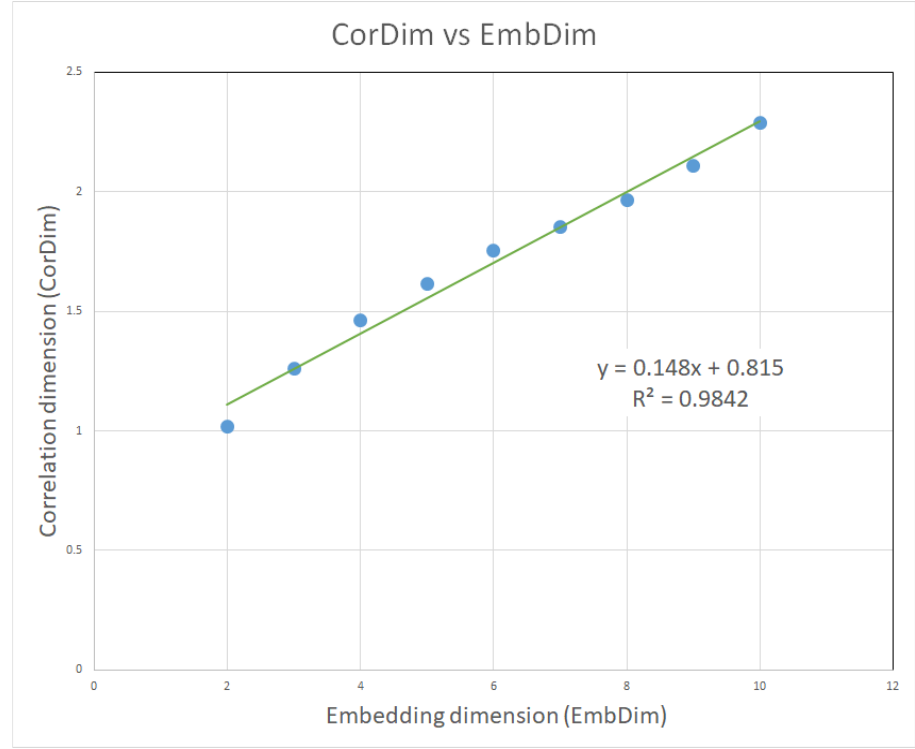
Figure 16. The slope of the autocorrelation dimension versus the embedding dimension for the normal area.